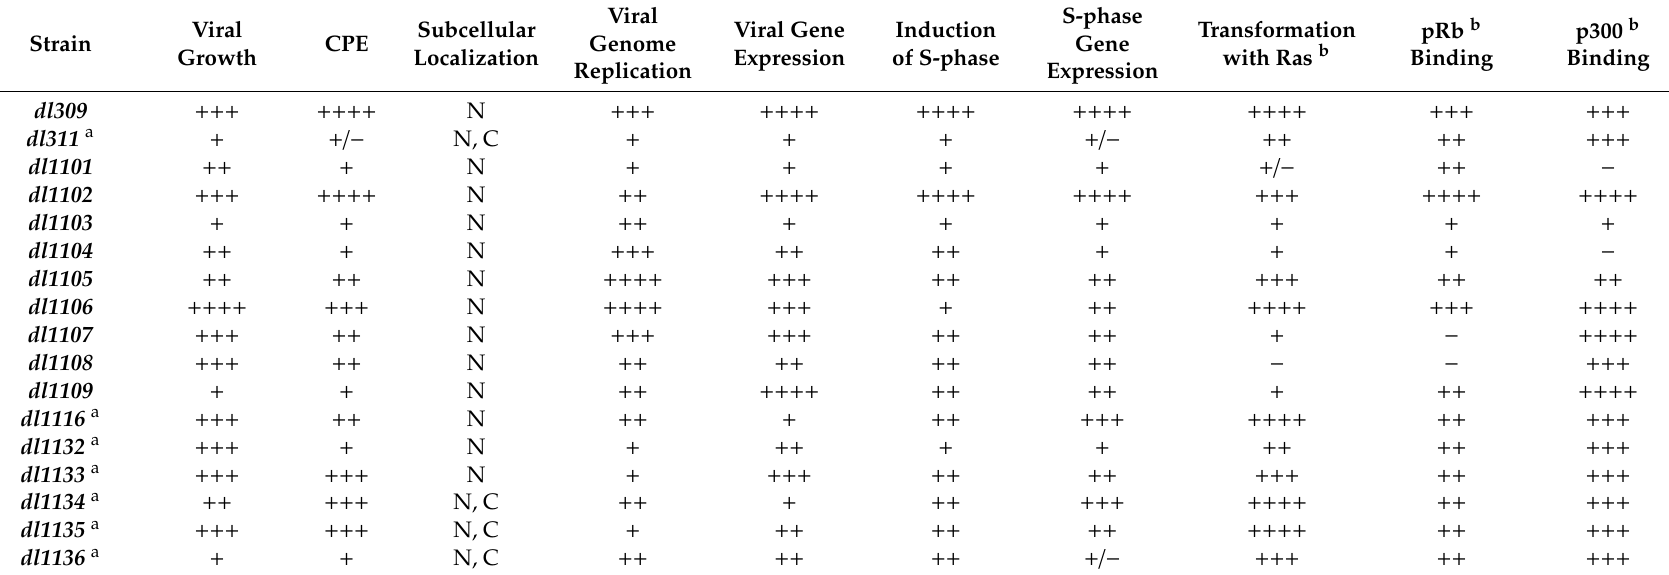
Table 1. Summary of characteristics of E1A exon 1 and 2 deletion mutants. The number of plusses ( + ) indicates how strong the given e ff ect is, a minus ( − ) indicates that this was not observed, a ( +/ − ) indicates a very weak e ff ect. N—nuclear,